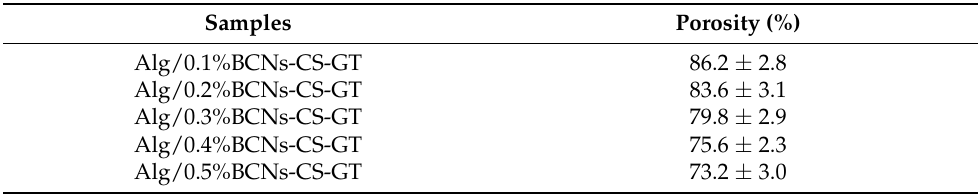
Table 1. Total porosity of Alg/BCNs-CS-GT composite scaffolds.